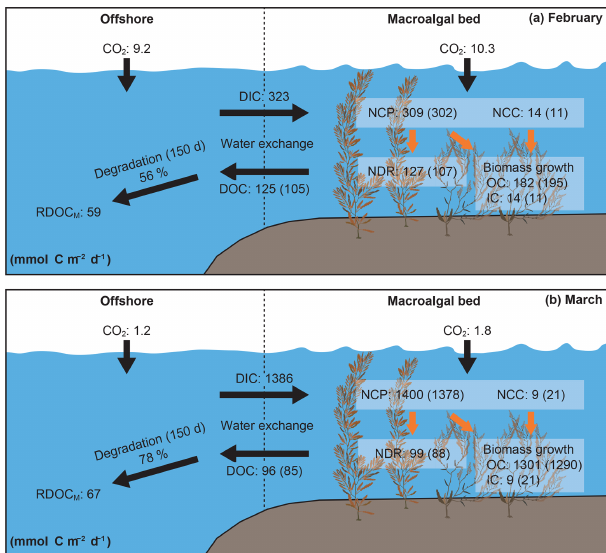
Figure 7. Carbon flows and community metabolism (NCP – net community production; NCC – net community calcification; NDR – net DOC release) in the macroalgal bed. NCP, NCC, and NDR were calculated using the results of field-bag experiments (details are available in Table S1). The carbon flows due solely to macroalgae are shown in parentheses. Biomass growth in terms of organic car- bon (OC) was calculated by subtracting NDR from NCP. Biomass growth in terms of inorganic carbon (IC) was the same as NCC. DIC and DOC flows via water exchange were estimated by mass- balance modeling (details are available in Table 3). Community metabolism, biomass growth, and DOC outflow indicate the sum of macroalgal and planktonic carbon flows. Carbon fluxes were cal- culated in units of millimoles per square meter of the surface area of the macroalgal bed per day. RDOC M indicates refractory DOC released by